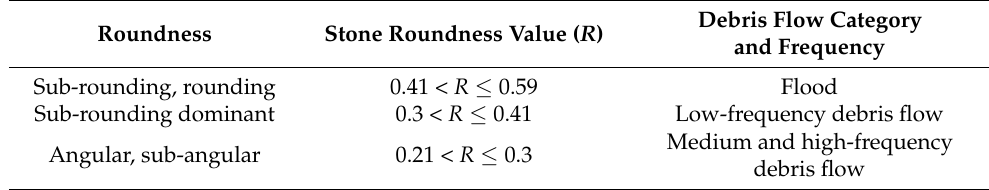
Figure 7. Flow chart for the identification of low-frequency debris flow gullies. Table 4. Debris flow frequency identification based on